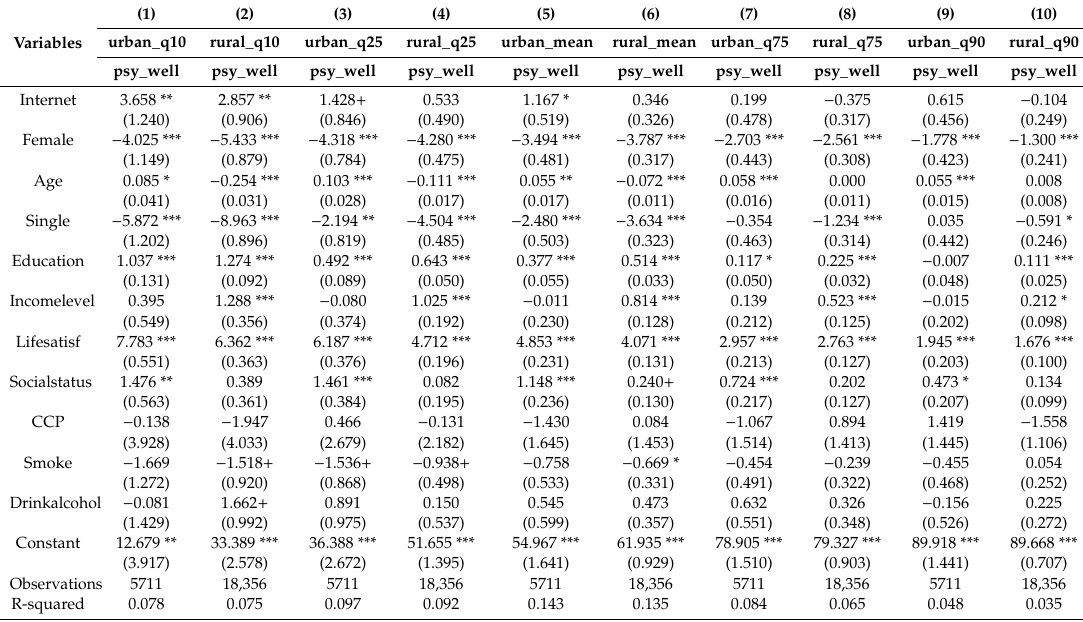
Table 2. RIF (re-centered influence function) regression of di ff erent statistics for non-agricultural and agricultural hukou